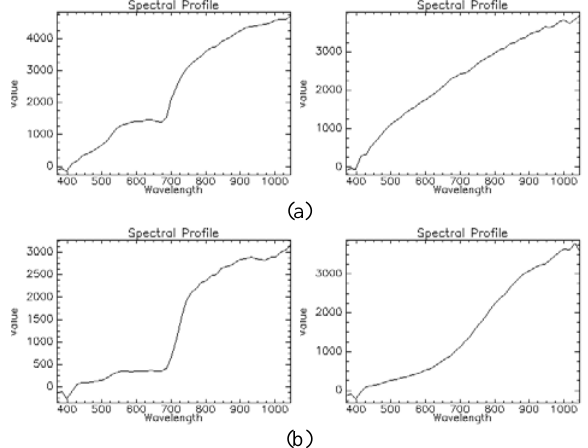
Figure 5. Spectral reflectance curves of the normal and leakage affected area: (a) paddy field and (b) forest land